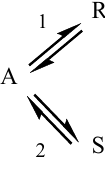
Figure 5. Parallel reaction system.